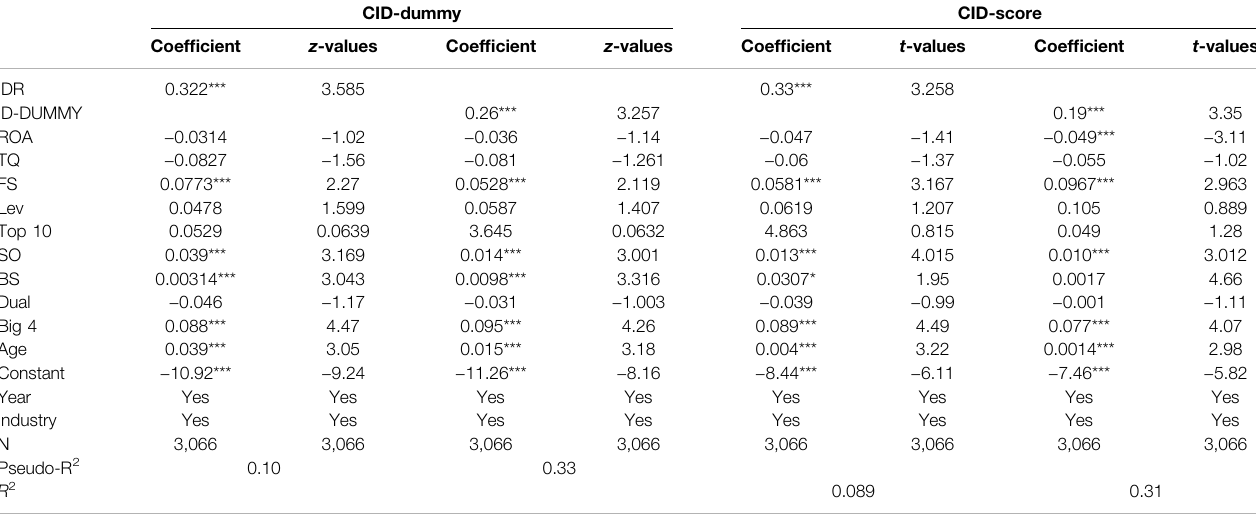
TABLE 6 | Effect of Independent directors on